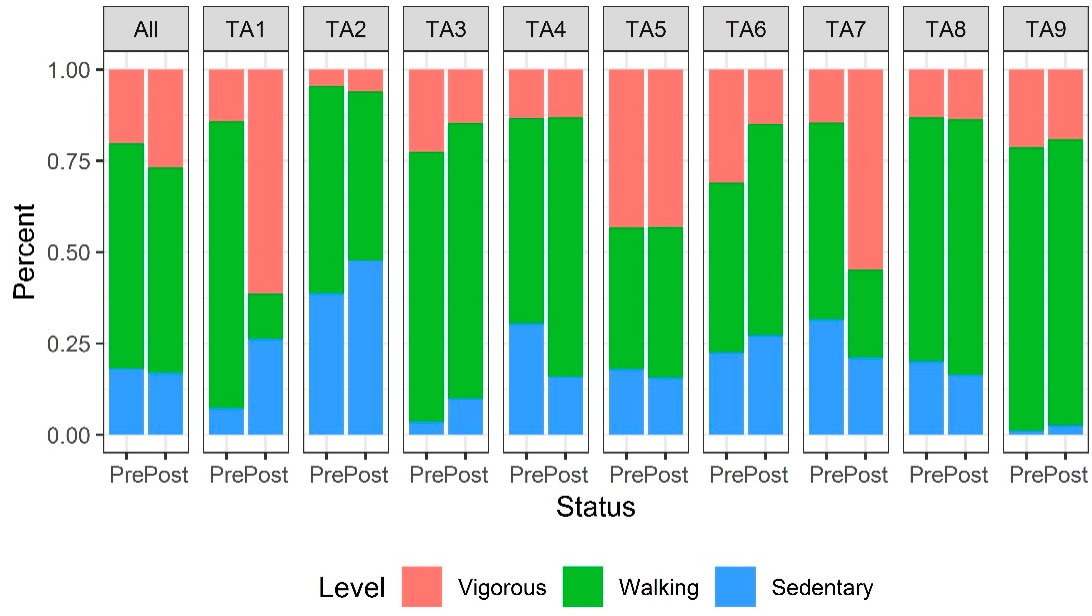
Figure 1. Distribution of physical activity levels in Garden Grove Park pre- and post-intervention. The numbers of observed person-periods pre-intervention and post-intervention overall and within each target area (TA) is listed in Table 2.